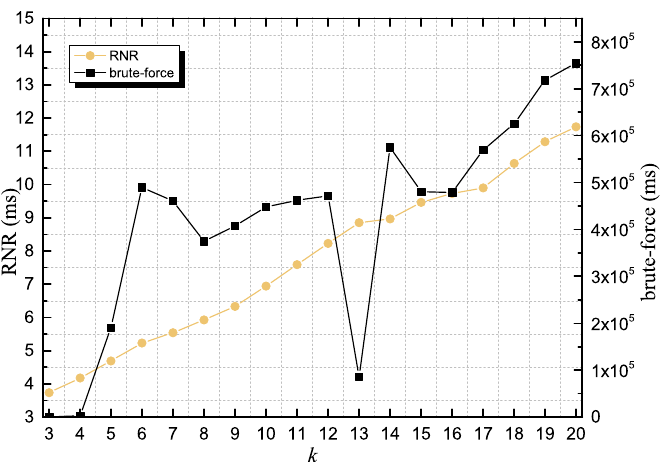
Figure 5. CPU time of RNR and the brute-force algorithm as k increases from 3 to 20 using a fixed δ of 5.